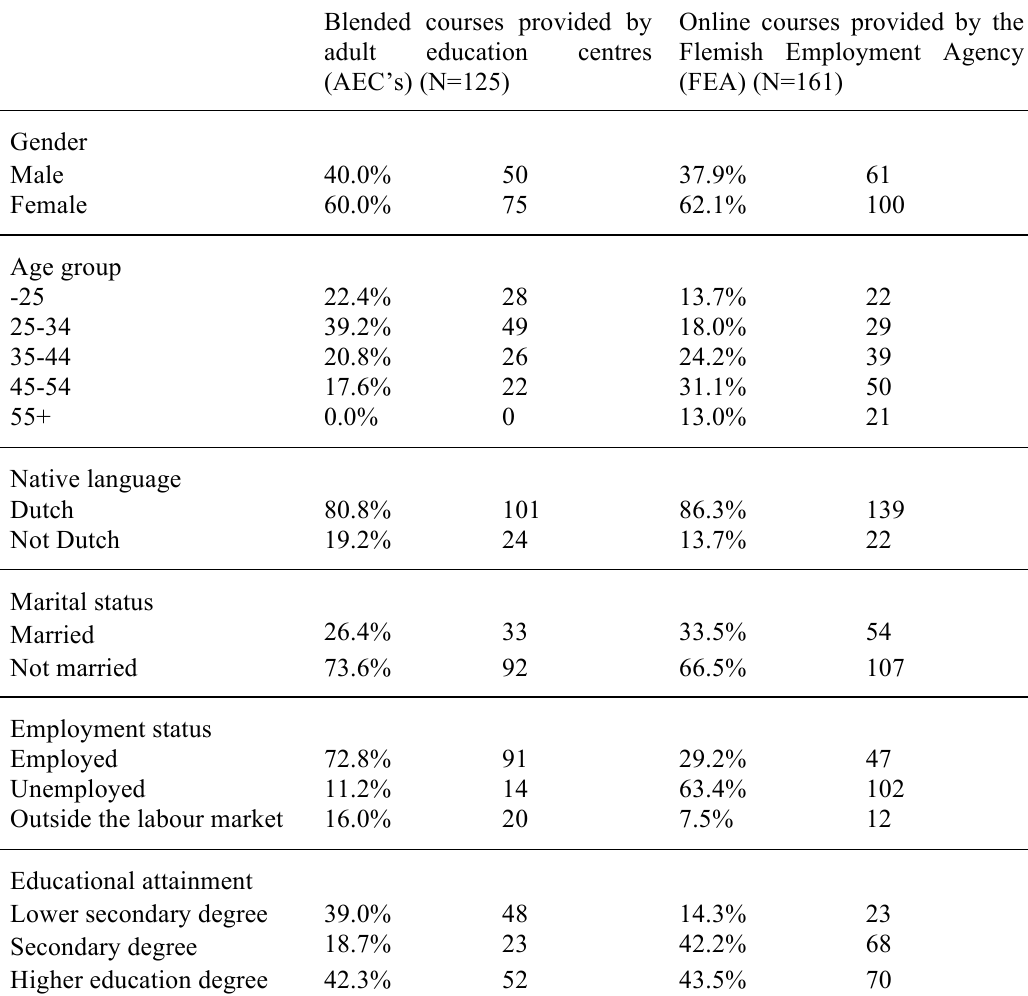
Table 1 : Participants’ socio-demographic variables by course provider.